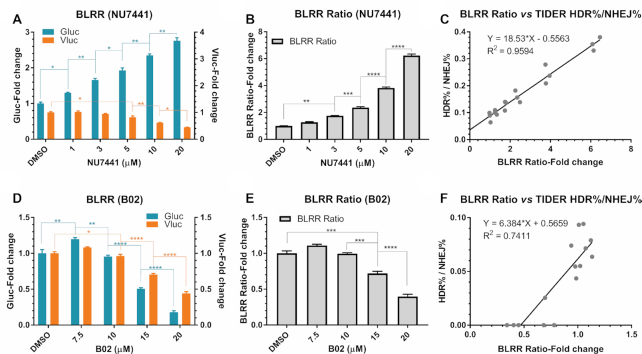
The BLRR assay can detect altered dynamics for DSB repair induced by small-molecule modulators. (A) BLRR activity reveals dose-dependent HDR-enhancing and NHEJ-suppressing effects of NU7441. BLRR cells were transfected with pX330-gRNA and trGluc and treated with NU7441. BLRR analysis of conditioned media revealed an increase in Gluc signal and a decrease in Vluc signal with increasing dosage of NU7441. BLRR signals were normalised against cell viability and results are shown as the fold change relative to DMSO-treated controls (mean ± SEM of three biological replicates). Representative data for three independent experiments are shown. (B) BLRR ratio displaying a dose-dependent increase in HDR events for NU7441. The BLRR ratio is Gluc activity divided by Vluc activity, normalised against DMSO-treated controls (mean ± SEM of three biological replicates). (C) TIDER analysis of A (Supplementary Figure S6A, B) showing a strong linear correlation between BLRR ratio and HDR%/NHEJ% (R2 = 0.9594. (D) The BLRR assay reveals dose-dependent HDR suppression by B02. BLRR cells were treated with B02 prior to transfection with pX330-gRNA and trGluc. BLRR analysis of conditioned media demonstrated a significant reduction in Gluc and NHEJ signals starting at 15 μM compared with the DMSO-treated control. BLRR signals were normalised against cell viability and results are shown as the fold change relative to DMSO-treated controls (mean ± SEM of three biological replicates). Representative data for three independent experiments are shown). (E) BLRR ratio showing a dose-dependent suppression of HDR by B02. The BLRR ratio is shown as the fold change relative to DMSO controls (mean ± SEM of three biological replicates). (F) TIDER analysis of D (Supplementary Figure S7A, B) reveals a linear correlation between BLRR ratio and HDR%/NHEJ% (R2 = 0.7411). Significance was calculated using one-way ANOVA compared with the DMSO group, followed by Tukey's post-hoc test (*P < 0.05, **P < 0.01, ***P < 0.001, ****P < 0.0001).